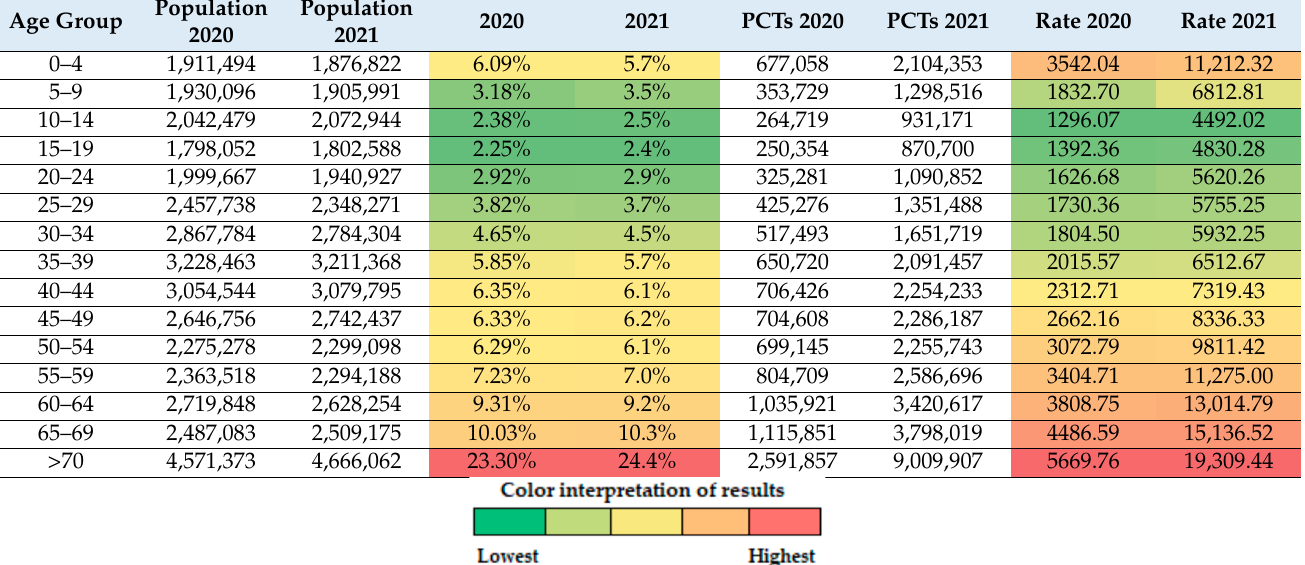
Table 2. The table shows the numbers of patients served with a PCT in 2020 and 2021 with age groups and the population size per 10,000